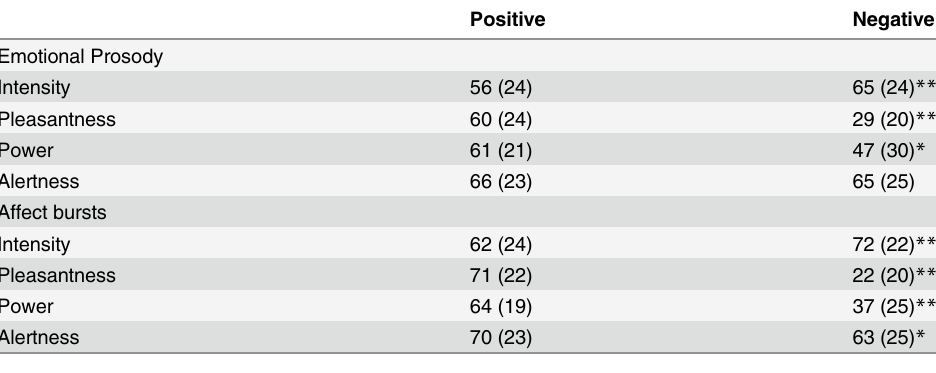
Table 4. Mean ratings for the continuous measures for each valence.